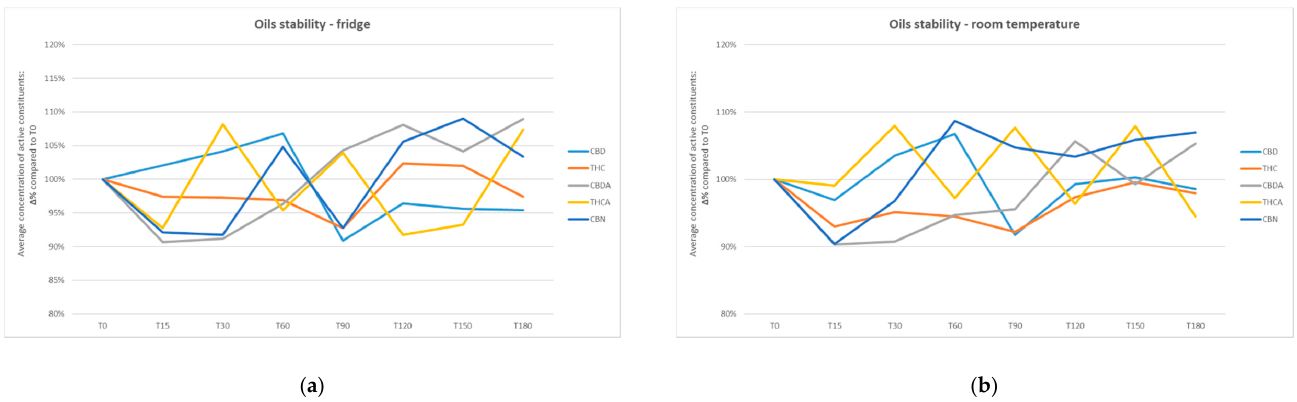
Figure 1. Oils stability: average concentration of active constituents compared to T0. ( a ) Oils stability in fridge; ( b ) oils stability at room temperature. T0: initial conditions; T 15: 15 days; T 30: 30 days; T 60: 60 days; T 90: 90 days; T 120: 120 days; T 150: 150 days; T 180: 180 days. Standard deviation for oils has been detailed in Table 2.